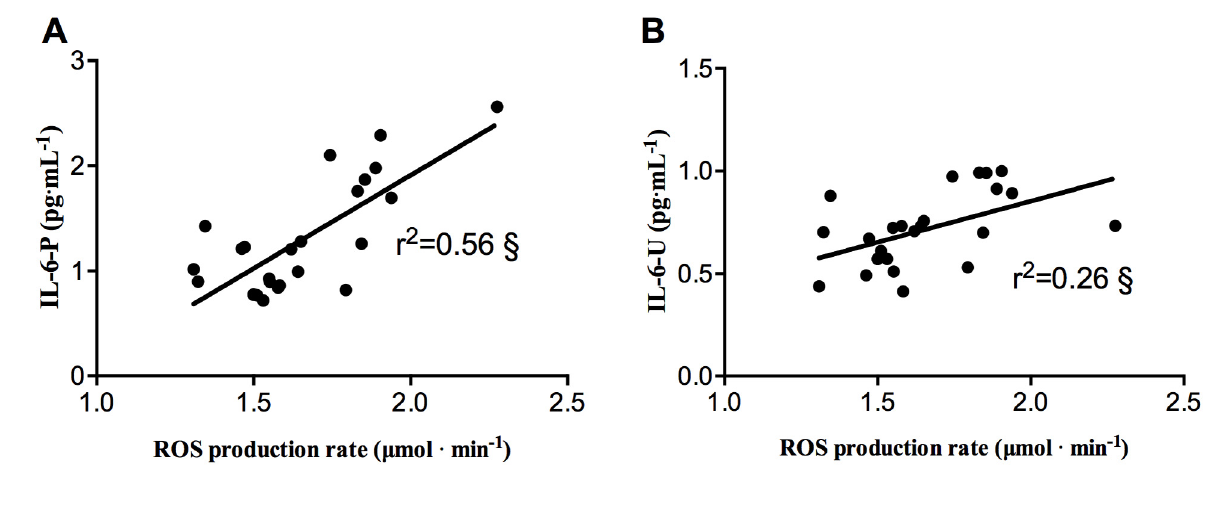
Fig 5. ROS-Interleukin correlation at Pre-Race in FR. Plots of ROS production rate levels ( μ mol . min -1 ) versus: A) IL-6 in plasma (IL-6-P) and B) IL-6 in Urine (IL-6-U). The significant (§ P < 0.001) linear relationship (solid line) is also shown and the correlation coefficient (r 2 ) reported in each